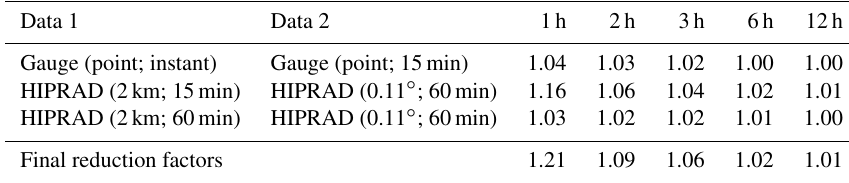
Table 2. Relative differences in annual maxima averaged over 4 years at different temporal and/or spatial